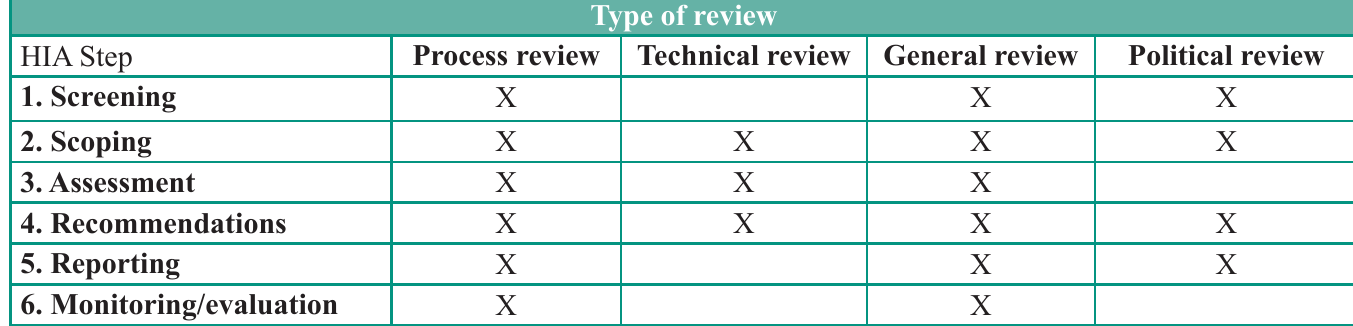
Table 5: Types of review suggested at each HIA